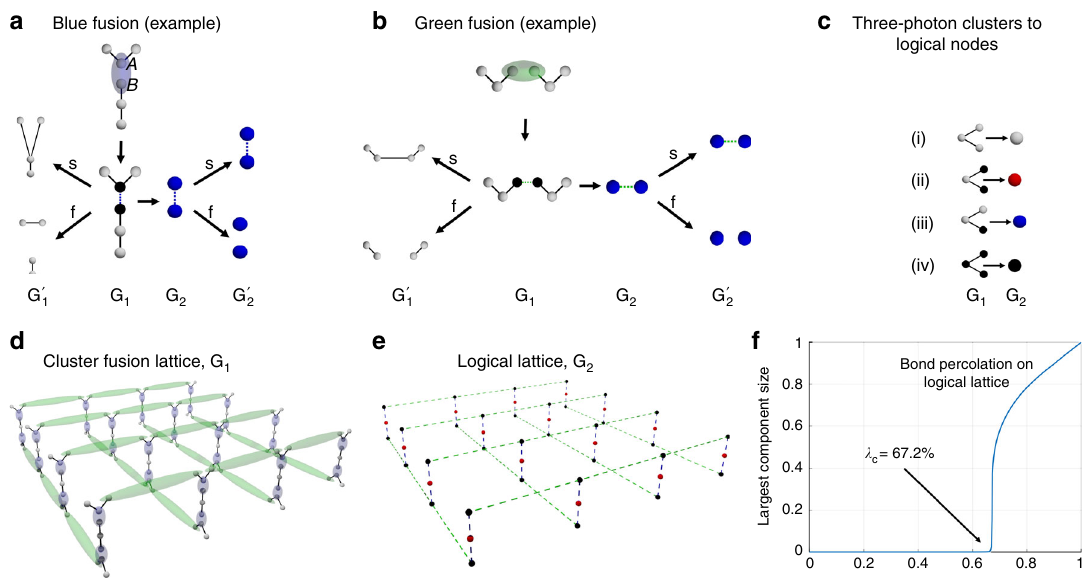
Fig. 4 Mapping two-photon fusions with many three-photon clusters to bond percolation on a logical graph. a , b Examples of two types of two-photon fusion operations, and their post-measurement states for success and failure outcomes. The linear – optical circuits for these (blue and green) fusions are shown in Figs. 2 and 3 of ref. 18 , respectively. From a graph connectivity point of view, two-photon fusion can be interpreted as coloring the measured photons black, and if the fusion succeeds, drawing a new bond between the black photons. c We map three-photon clusters to nodes of a logical graph of color based on how many photons in the cluster are left unmeasured. d An example of a cluster-fusion lattice G 1 with both kinds of fusions, and ( e ) the corresponding logical graph G 2 . f The bond-percolation curve and threshold ( λ c ≈ 0.672) of G 2 . If each fusion attempt in ( d ) succeeds with probability λ > ′ λ which is a giant-connected component (GCC) consisting of red nodes of G 2 . This implies the creation of a random c , it results in a random graph G 2 photonic cluster state G ′ , which is a GCC of G 1 comprising the unmeasured photons — a resource renormalizable for universal cluster-model photonic 1 quantum